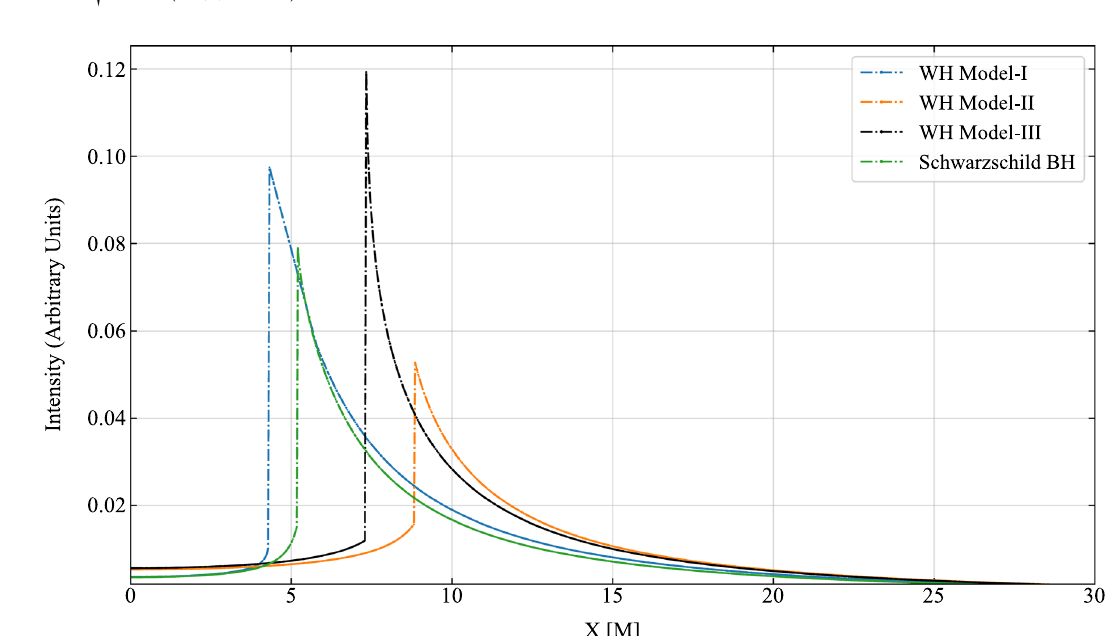
Fig. 5 Plots of the corresponding intensities using the infalling gas as seen by a distant observer in different WH geometries and for comparison, the Schwarzschild BH as well. The horizontal axis represents the radial distance of the distant observer from the black